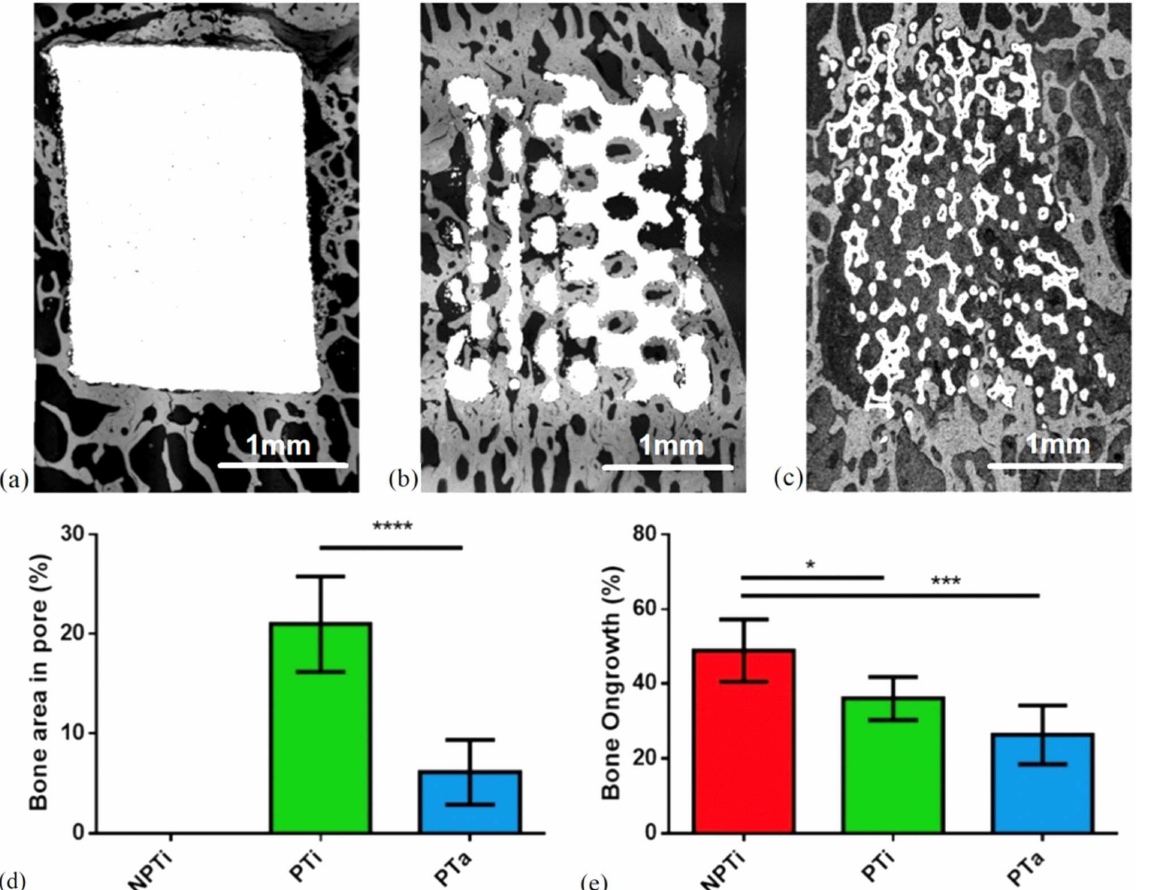
Figure 9. Backscattered-electron scanning electron micrographs displaying bone percentage for each cage type. ( a ) Nonporous titanium cage (NPTi), ( b ) 60% porous titanium cage (PTi), ( c ) porous tantalum cage (PTa), ( d ) bone area in cage pores, ( e ) bone ongrowth around cage. ( n = 5), * p < 0.05, *** p < 0.001, **** p <